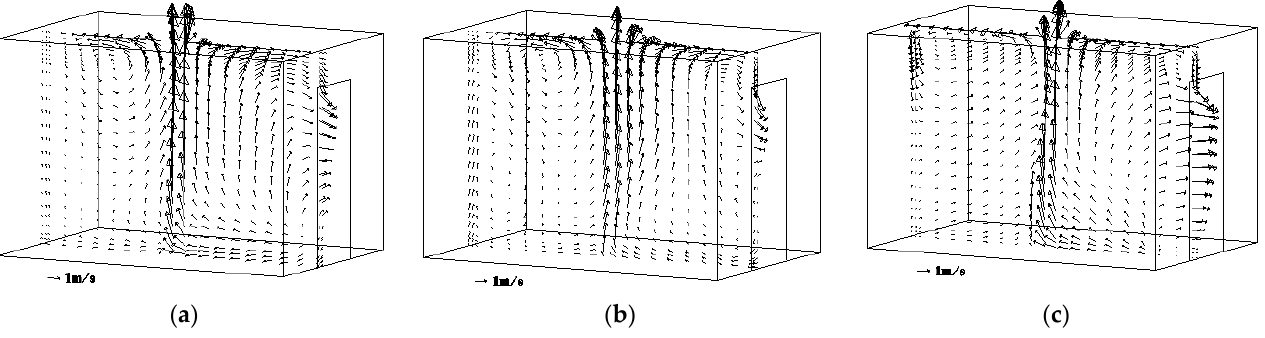
Figure 3. Predicted flow fields using ( a ) Tu 1, ( b ) Tu 2, and ( c ) Tu 3.